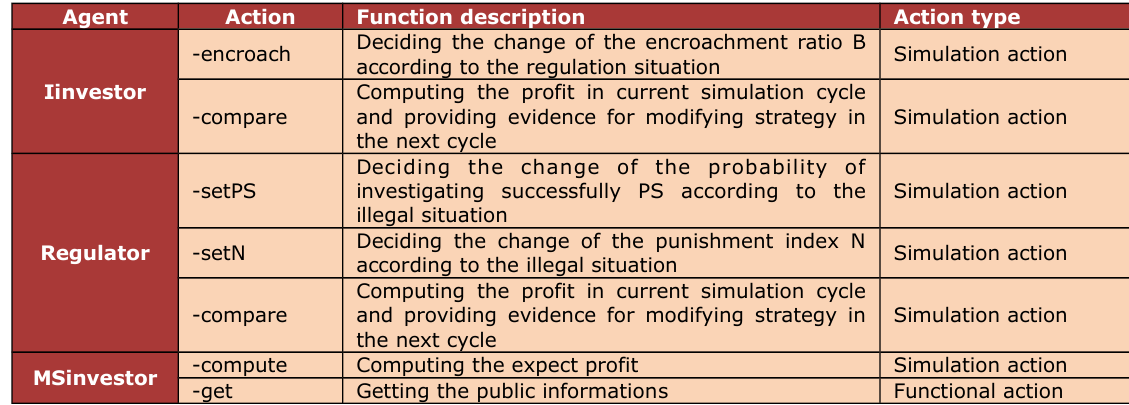
Table 2. The main actions of the simulation